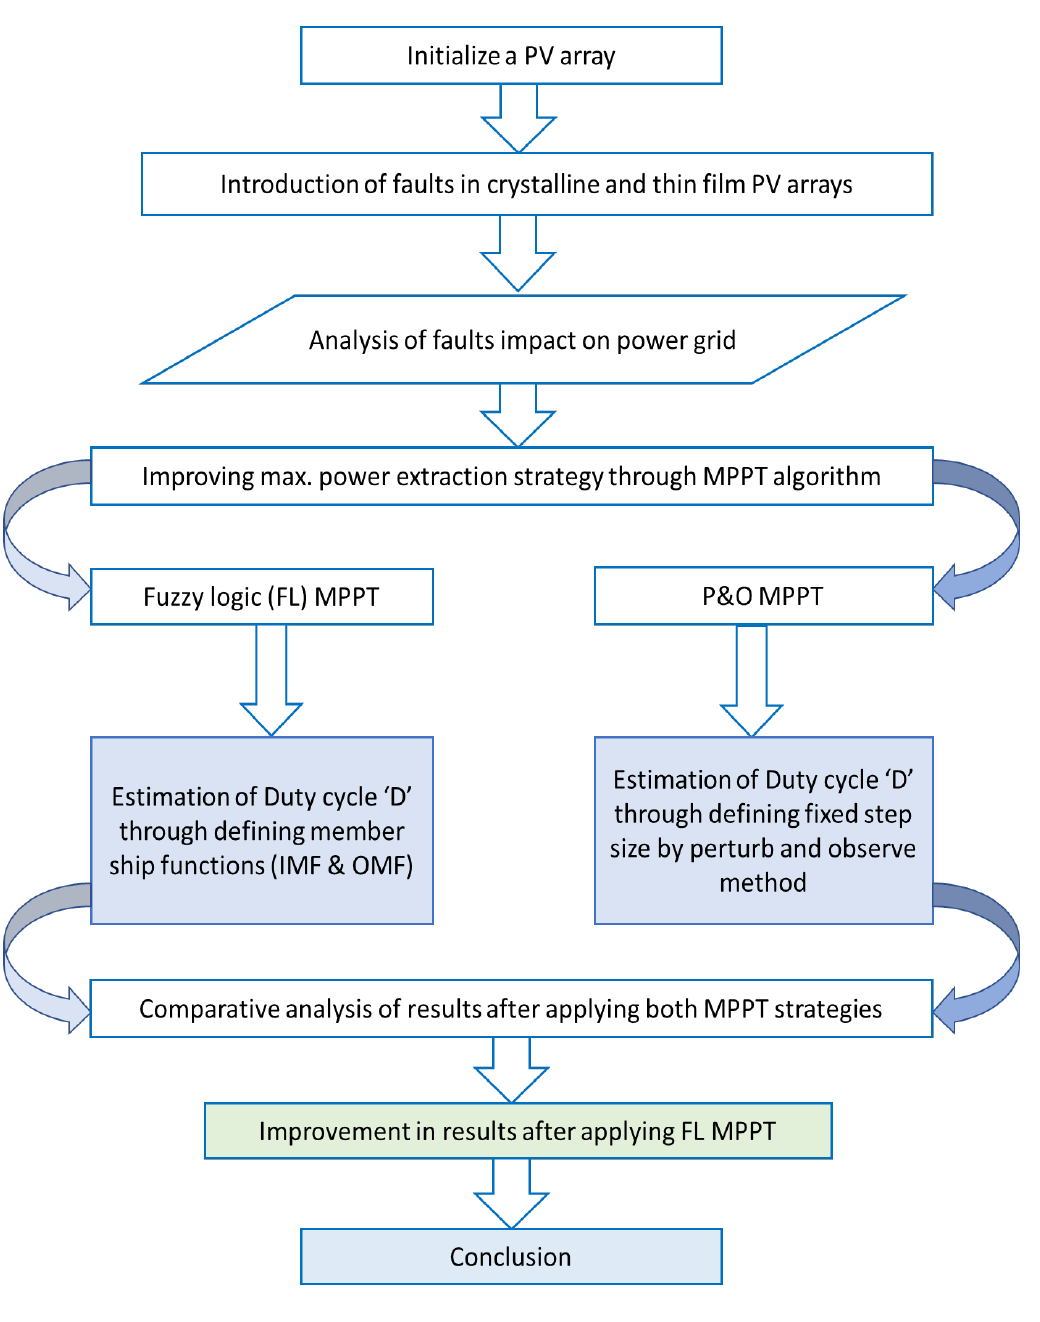
Figure 2. Flow diagram of the proposed MPPT scheme.